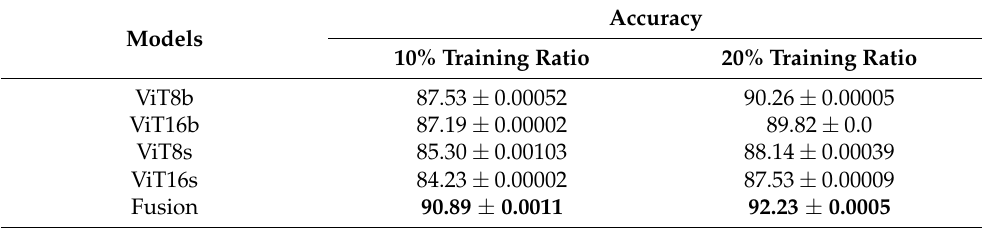
Table 6. Comparison with different ViT features on the NWPU-RESISC45 data set.